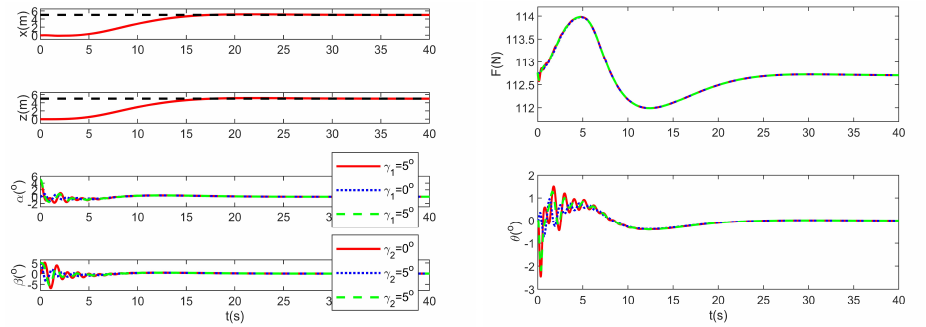
Figure 6. Simulations results for different initial swing angles.